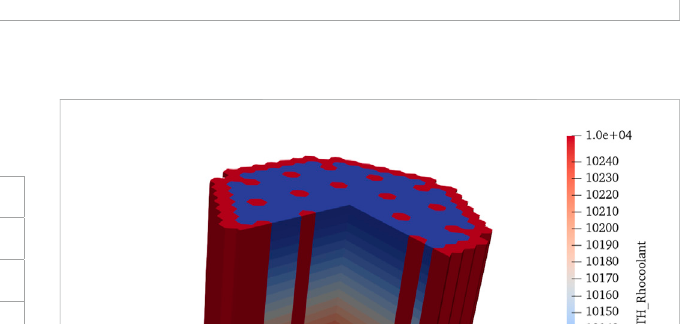
FIGURE 7 Temperature distribution of the fuel rod in the central assembly.